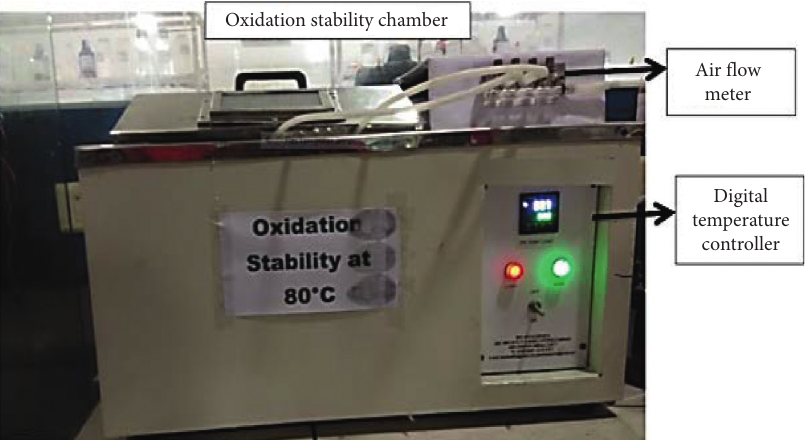
Figure 12: Oxidation stability